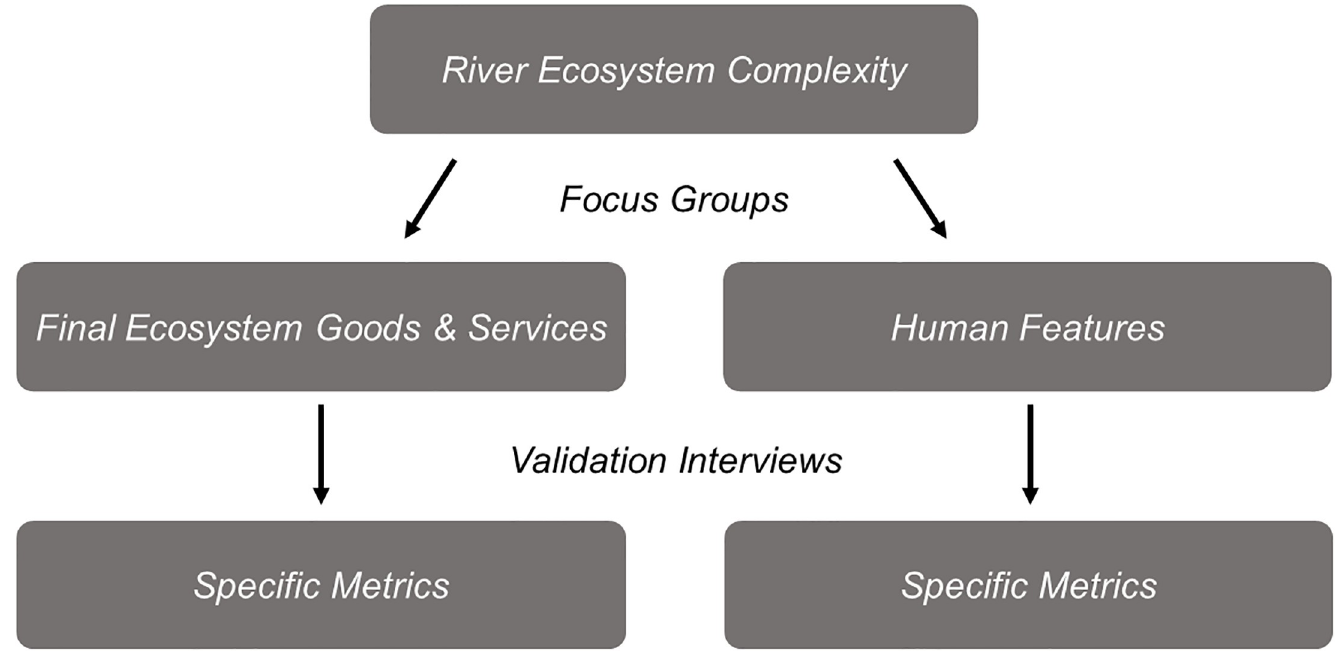
Fig 1. Methodology